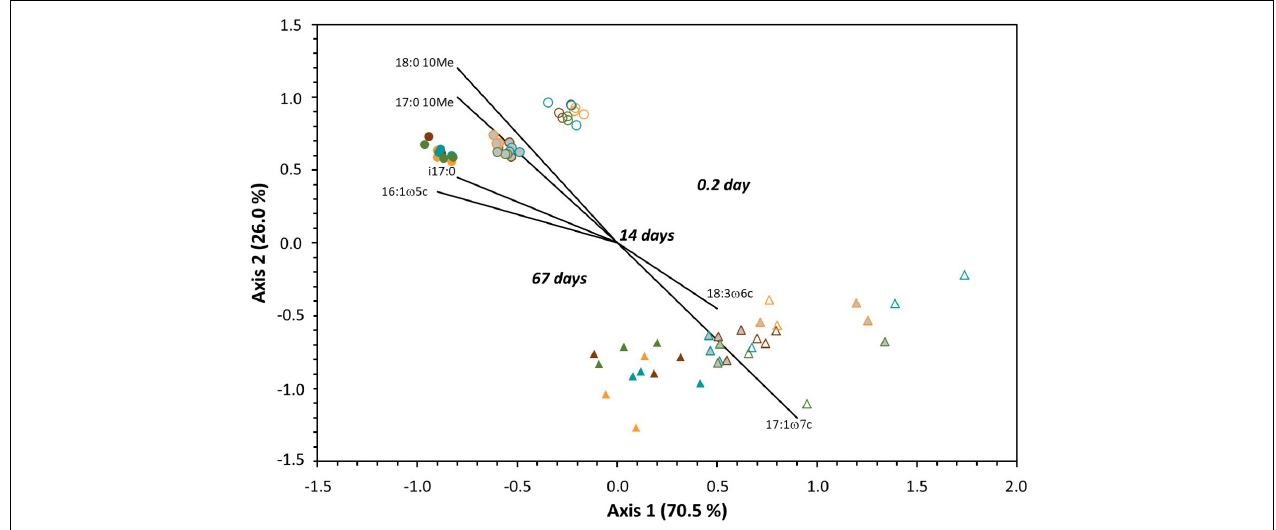
FIGURE 3 | Non-metric multidimensional scaling ordination of PLFA profiles extracted from the aspen (circles) and spruce (triangles) soil incubation units after different incubation times, including 4 h (empty symbols), 14 days (grayed symbols), and 67 days (filled symbols). Substrates are indicated with different colors, including brown for control, orange for glucose, green for aspen leaves, and blue for aspen roots.